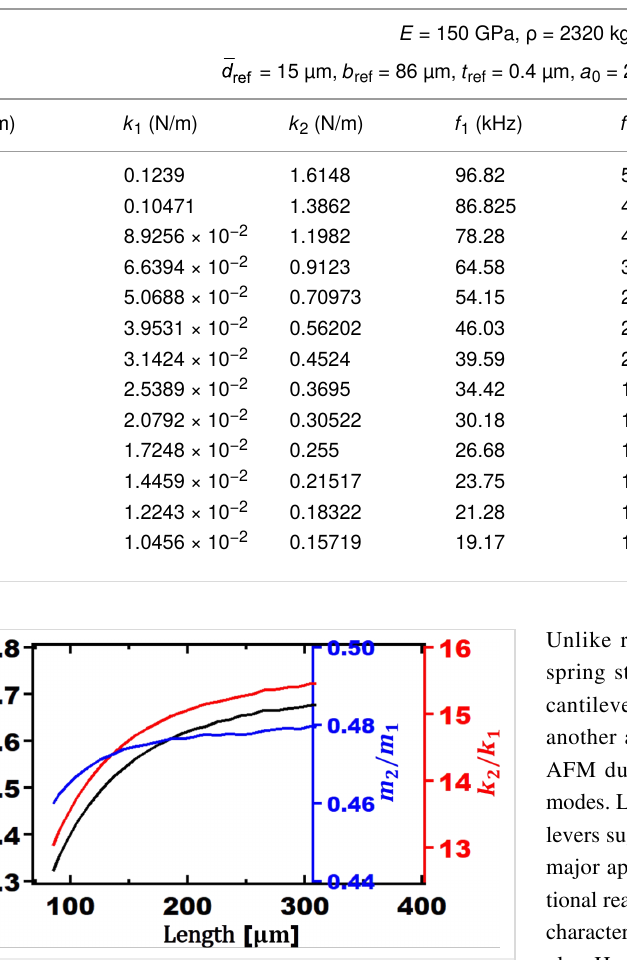
Table 2: Range of lengths for V-shaped cantilevers with calculated properties. Specifications of the V-shaped cantilever